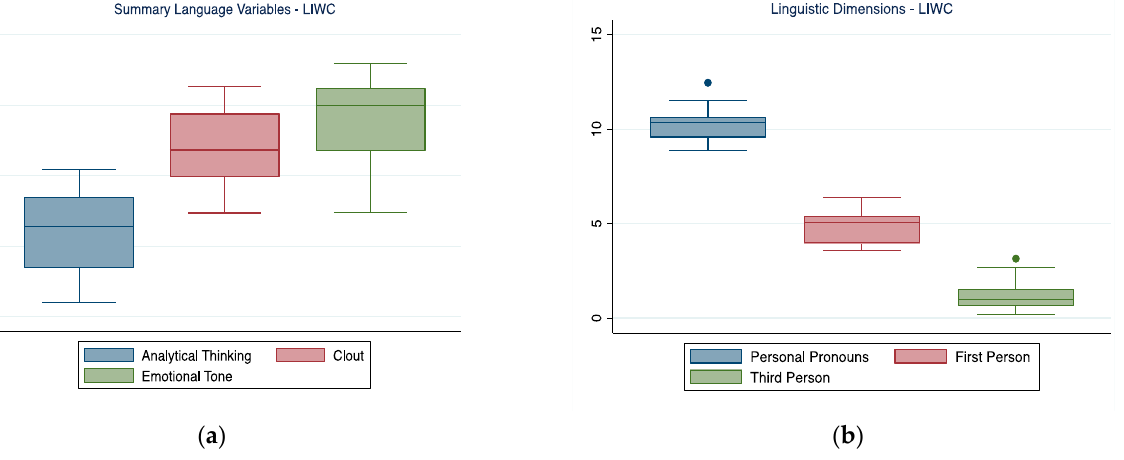
Figure 1. Summary language variables ( a ) and linguistic dimensions ( b )—LIWC. In the boxplot, the central horizontal line indicates the median, the other two lines indicate the first (lower line) and third (higher line) quartiles, the whiskers indicate the minimum and maximum values, and the dots indicate outliers.